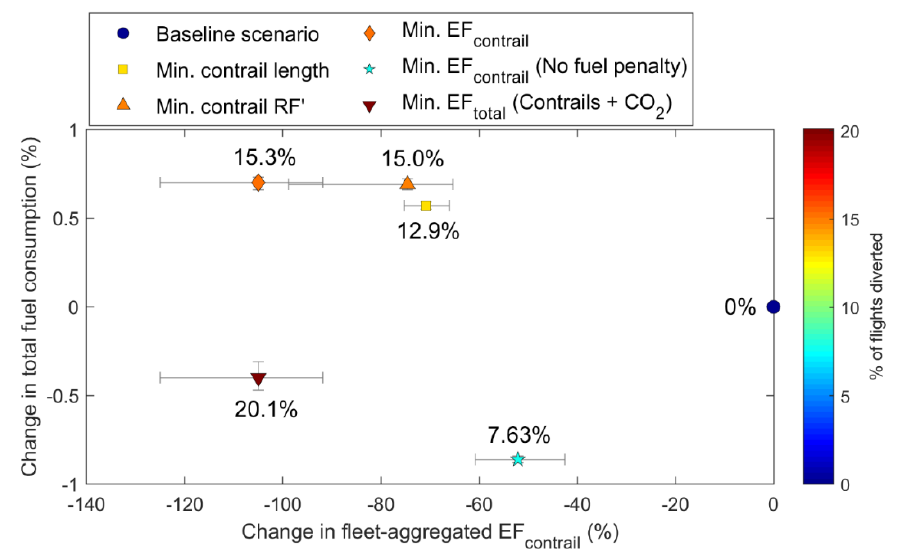
Figure 1. Percentage change in the aggregated contrail energy forcing (EF contrail ) and total fuel consumption (TFC; for all flights in the dataset) for vertical flight diversion strategies with five different objective functions relative to the baseline scenario. The strategies include selecting the flight trajectories with a minimum: (i) contrail length; (ii) local contrail radiative forcing (RF’; (iii) EF contrail ; (iv) EF contrail with an additional constraint where flights with no fuel penalty are diverted; and (v) EF total , including the EF of contrails and CO 2 . The percentage of flights diverted is shown in the symbol colour. Error bars denote the 95% CI.